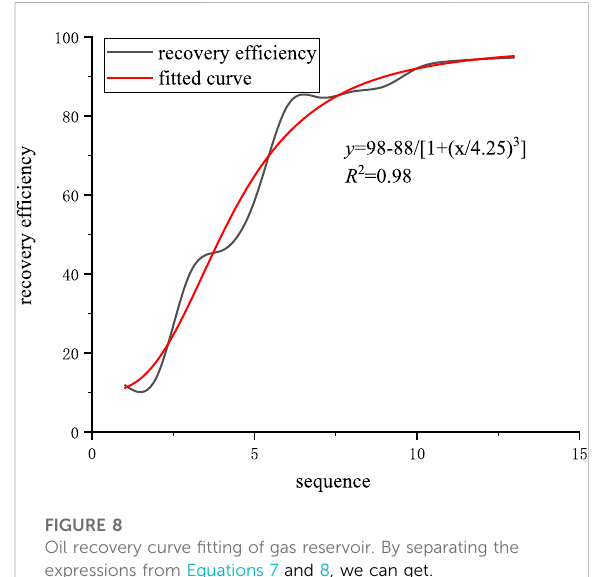
FIGURE 8 Oil recovery curve fi tting of gas reservoir. By separating the expressions from Equations 7 and 8, we can get.